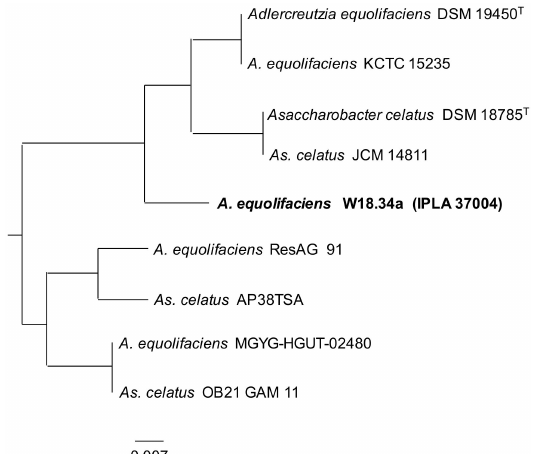
Figure 2. Phylogenetic relationships of Asaccharobacter celatus and Adlercreutzia equolifaciens strains (including W18.34a; IPLA 34007) obtained by comparison of their genome sequences.